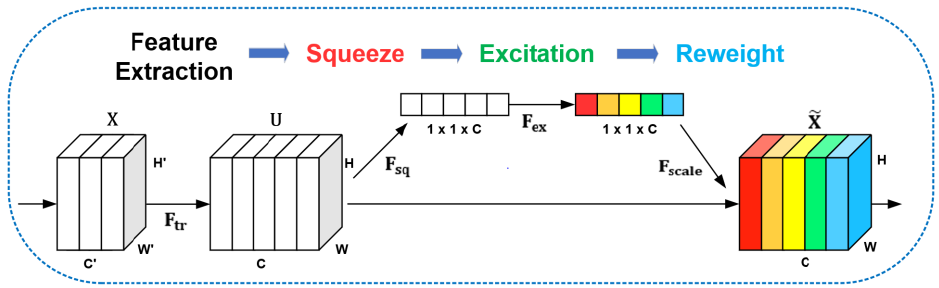
Figure 5. The schematic diagram of SEM.